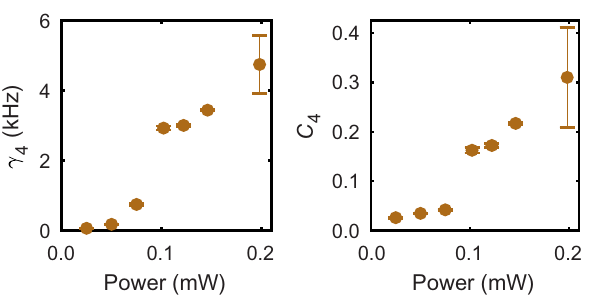
FIG. 10. Quantum emitter A: γ 4 and C 4 for orange excitation. The error bars denote one standard deviation.